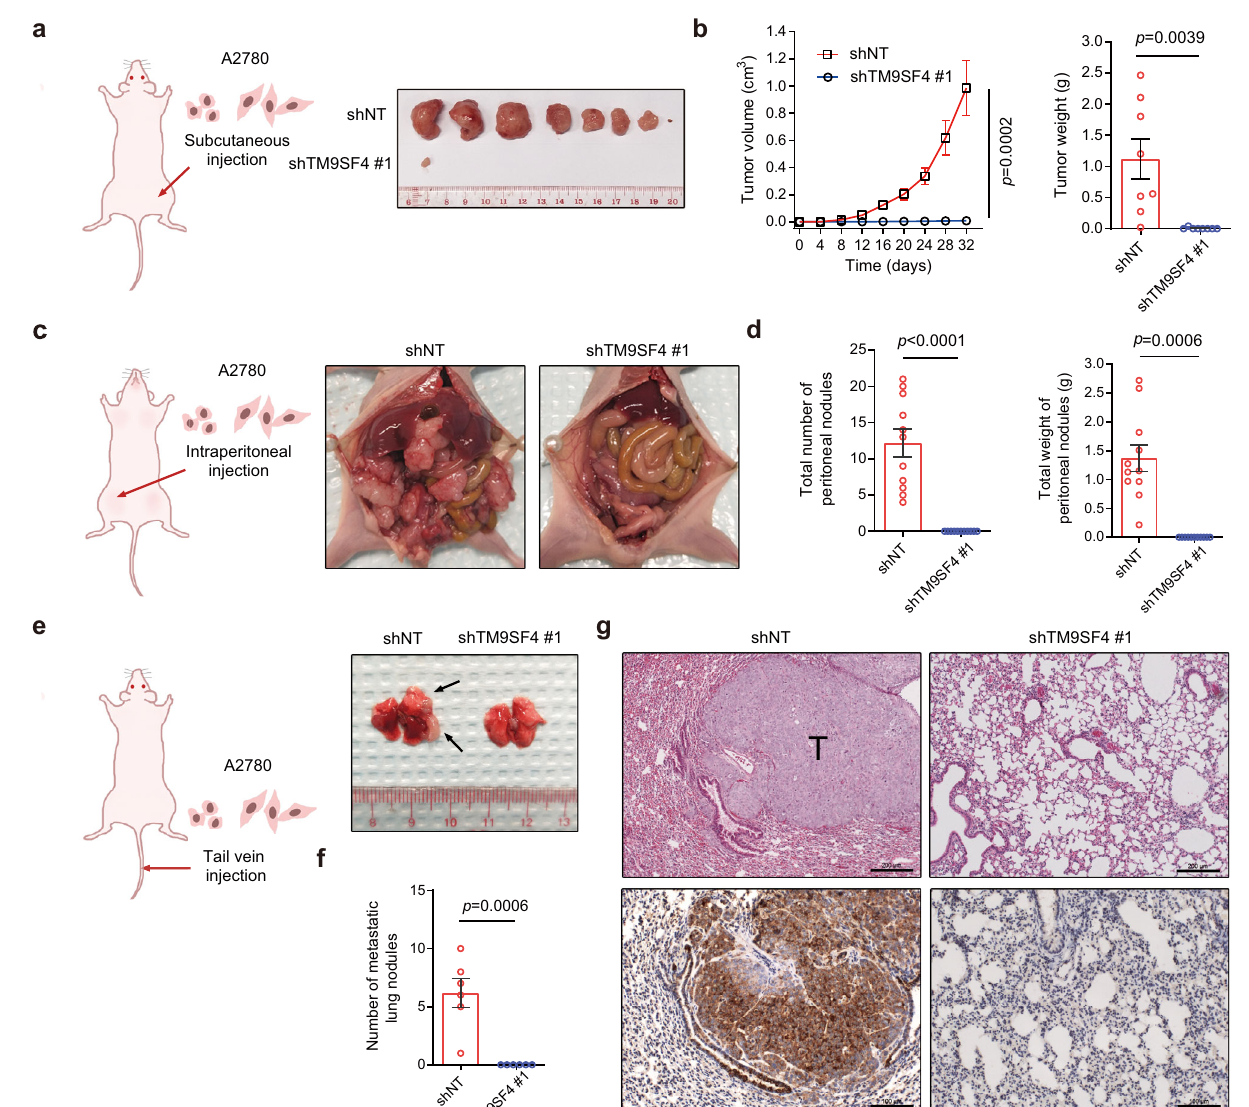
Fig. 6 | TM9SF4 silencing suppresses tumor initiation/growth and metastasis by A2780 cells in athymic nude mice. a , b TM9SF4 knockdown inhibited tumor initiation/growth. Control or TM9SF4 knockdown A2780 cells were injected sub- cutaneously into the hind leg of nude mice ( n =8 per group), followed by mea- surement of tumor sizes every 4days. Shown are the dissected tumors. c – g TM9SF4 knockdown inhibited tumor metastasis to peritoneal cavity and lung. Control or TM9SF4 knockdown A2780 cells were injected intraperitoneally, fol- lowed by measurement of peritoneal tumor nodules in number and weight on day 30 ( c , d ) ( n =11 per group). Control or TM9SF4 knockdown A2780 cells